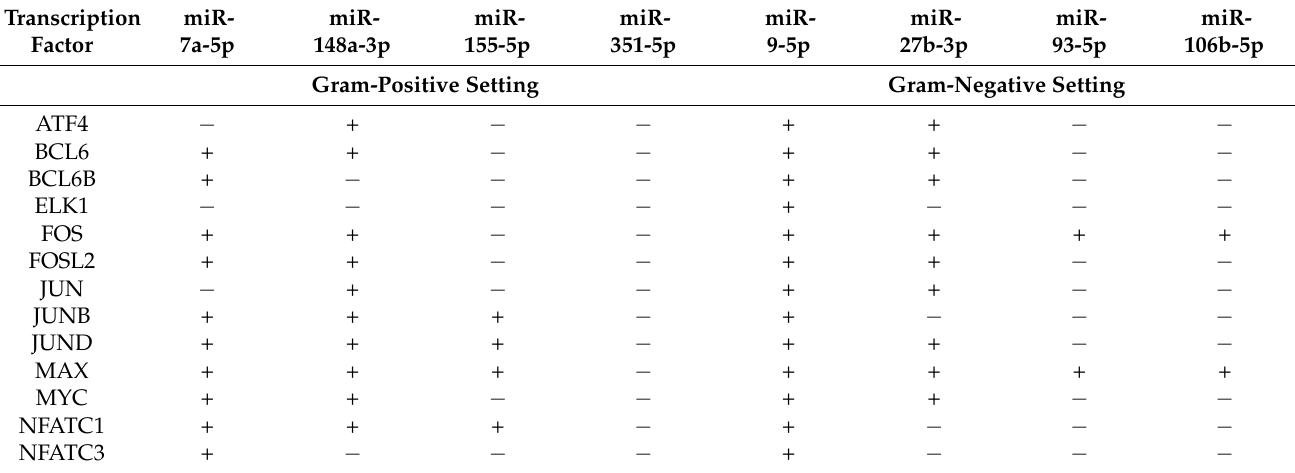
Table 1. Transcription factors that (i) are subject to influence by TLR signaling pathways and (ii) are capable of interacting with the promoter region of miRNAs altered after TLR stimulation as identified using the databases GeneCards v5.7 and KEGG. “+” indicates that the transcription factor binds the transcription factor binding site of the miRNA; “ − ” indicates